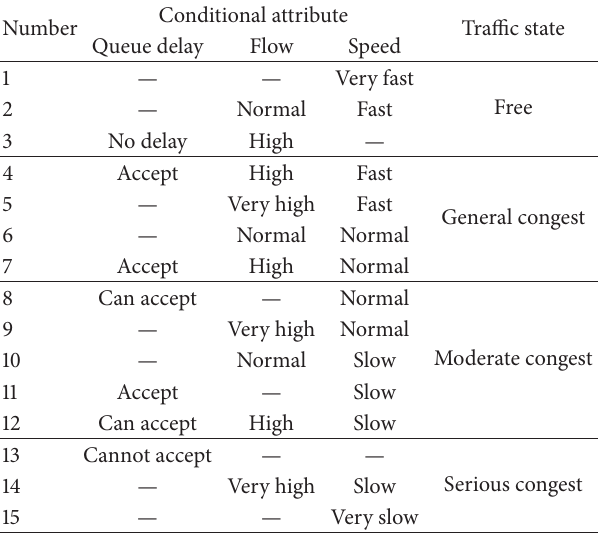
Figure 14: Results of assessment of traffic state. Table 8: Final decision rules.